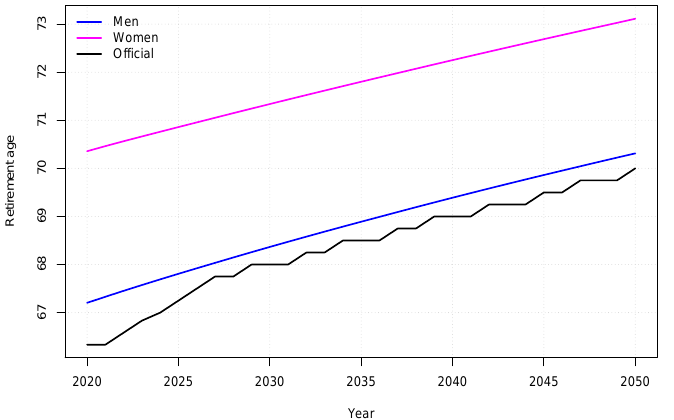
Figure 4. NLD: Legislated retirement age and age with remaining cohort life expectancy equal to the 18.26 years target.